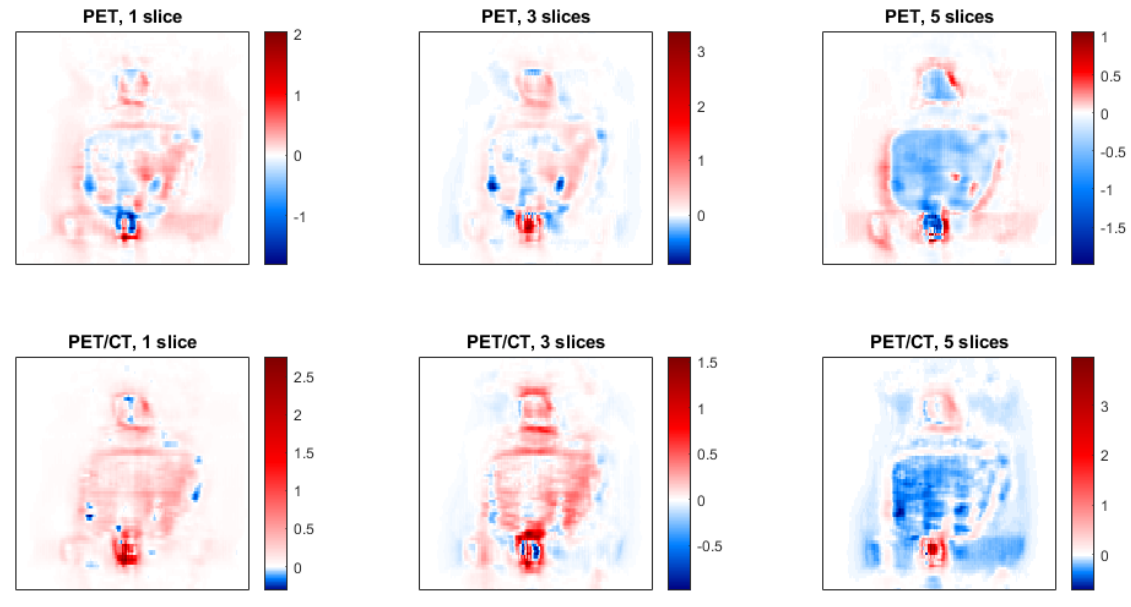
Figure 8. Images of the difference between the estimated images ( 68 Ga with Deep-PRC) and the reference ones ( 18 F) for each of the cases considered. Table 2. Quantitative analysis of the results over different regions.